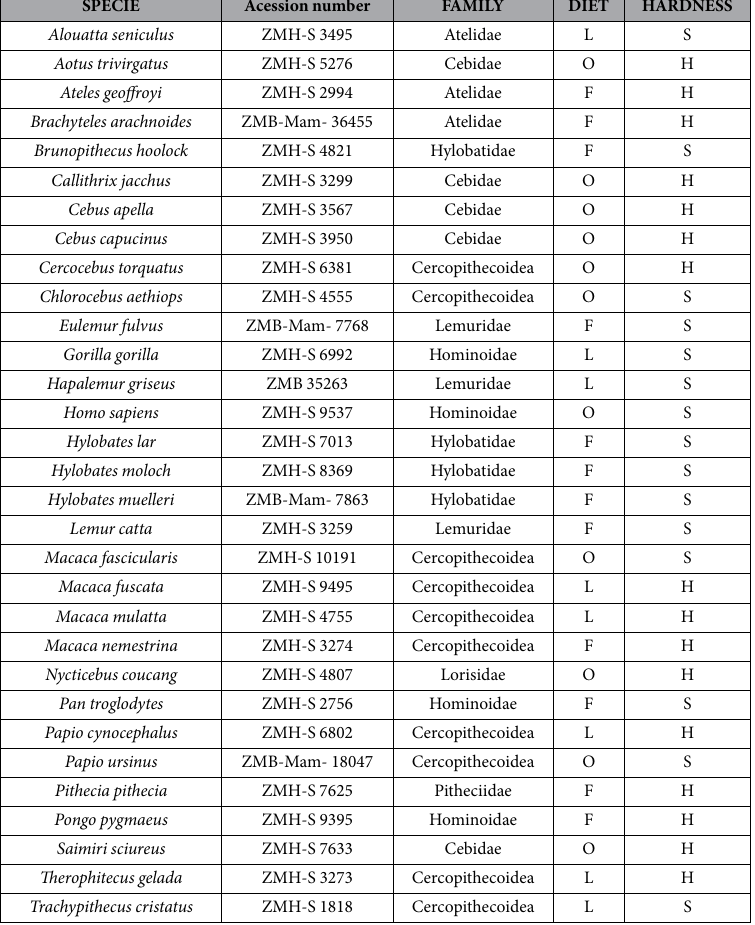
Table 1. List of primate species used in the present study. Museum Acronyms: ZMH = Centrum für Naturkunde, Hamburg, Germany; ZMB = Museum für Naturkunde Berlin, Germany. Families are according the classification of Wilson and Reader 72 and Arnold et al . 52 . Diet: O = Omnivore; F = Frugivore; L = Folivore. Hardness: H = Hard-food eaters; S = Soft-food